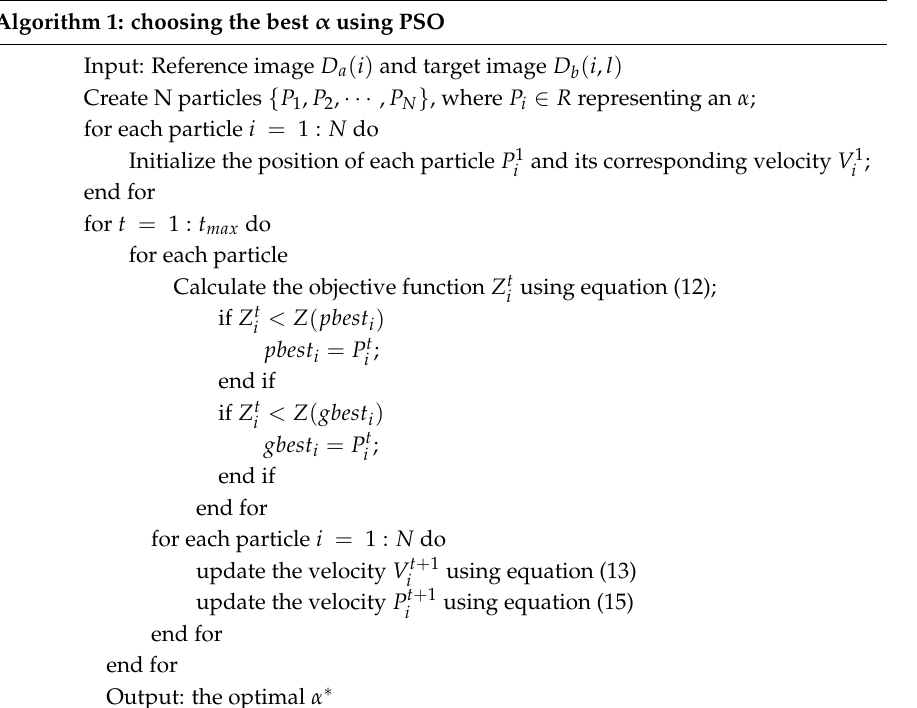
Algorithm 1: choosing the best α using